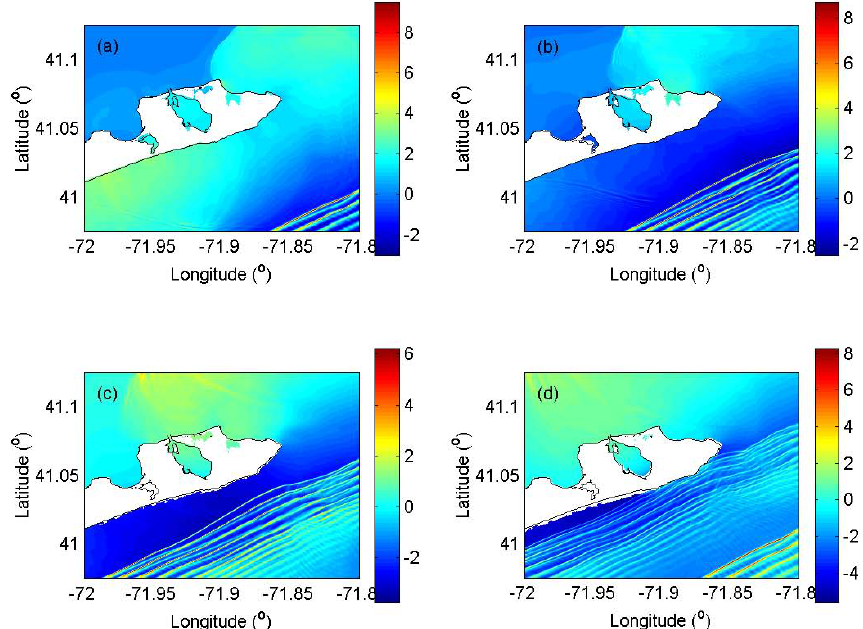
Fig. 26. Runup of an undular bore: (a) – (d) indicate the sequence in time with an interval of